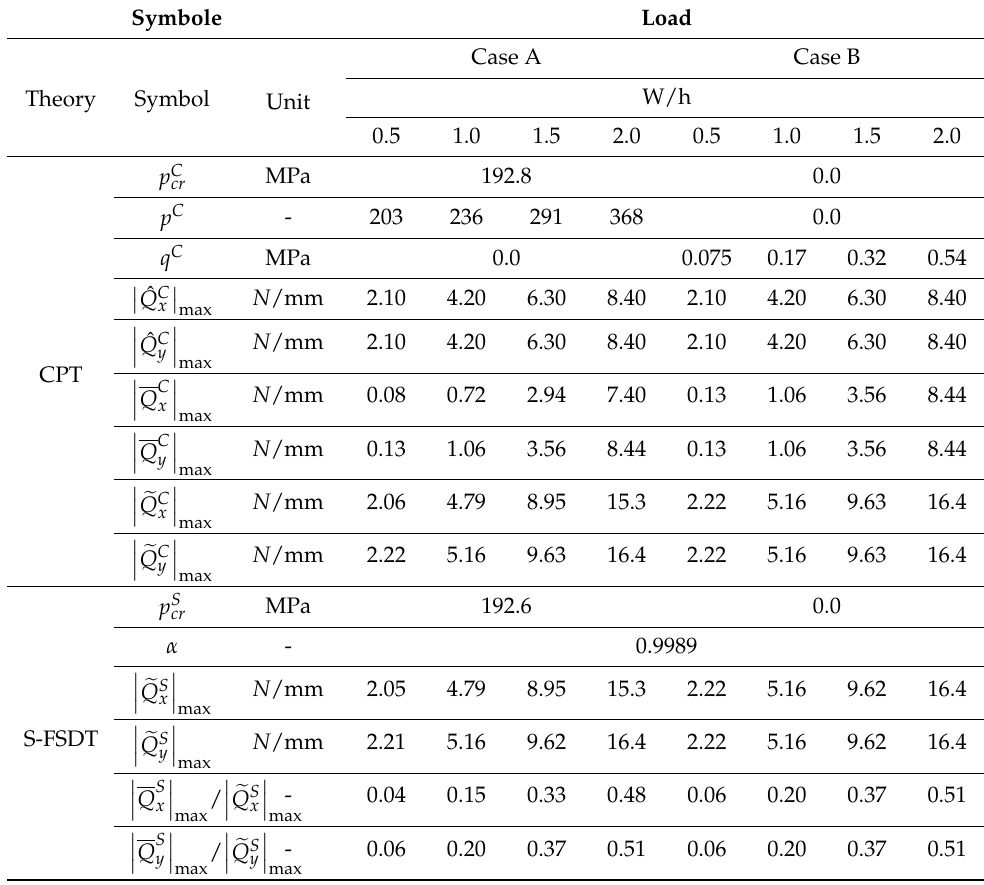
Table 1. Values of loads of the square plate and values of absolute maximal components and total transverse